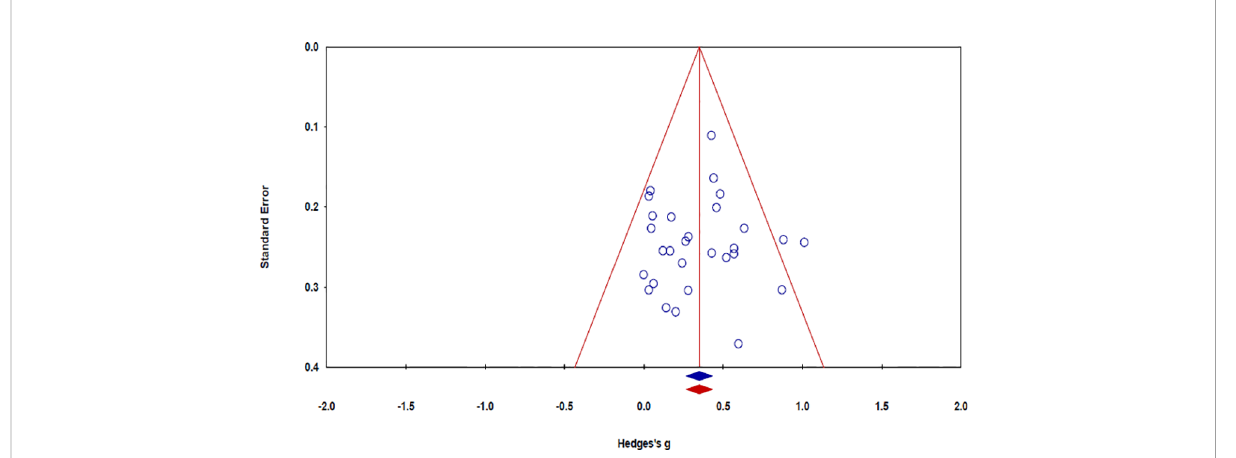
FIGURE 5 Funnel plot of the effect